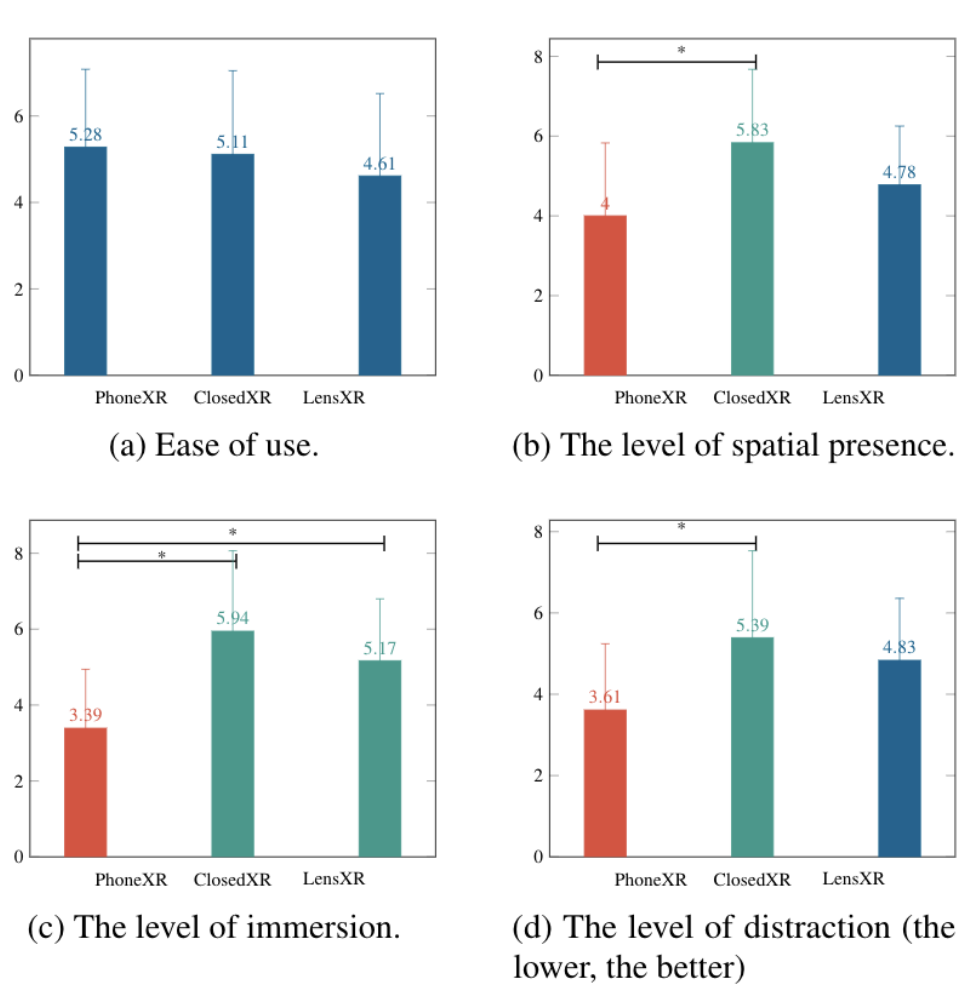
Figure 14. Survey results regarding the UX for VR application—statistical differences are indicated by color grouping and the “*” mark. The vertical axes represent the subjective levels in the 7-point Likert scale.